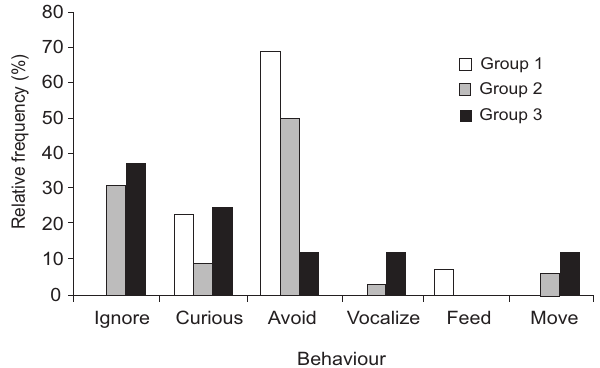
Figure 2. Relative frequency of different responses to the presence of observers in the three C. coimbrai groups at the Fazenda Trapsa, Sergipe,